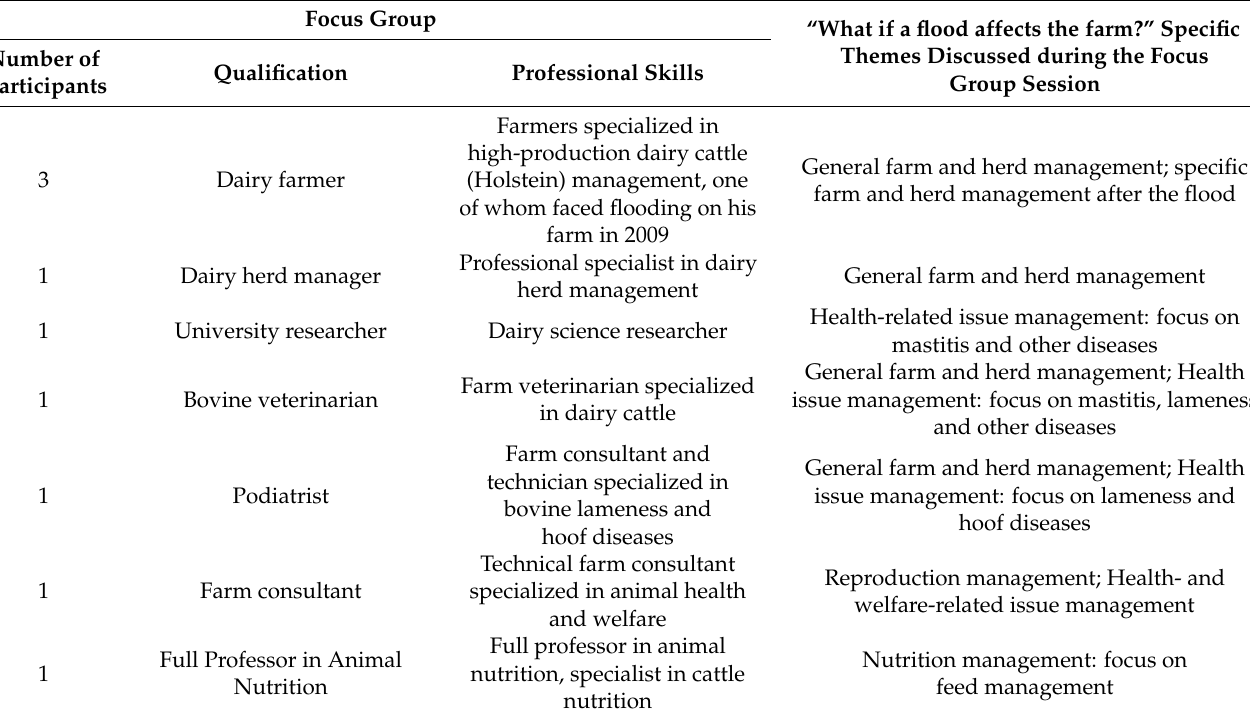
Table 1. Focus group